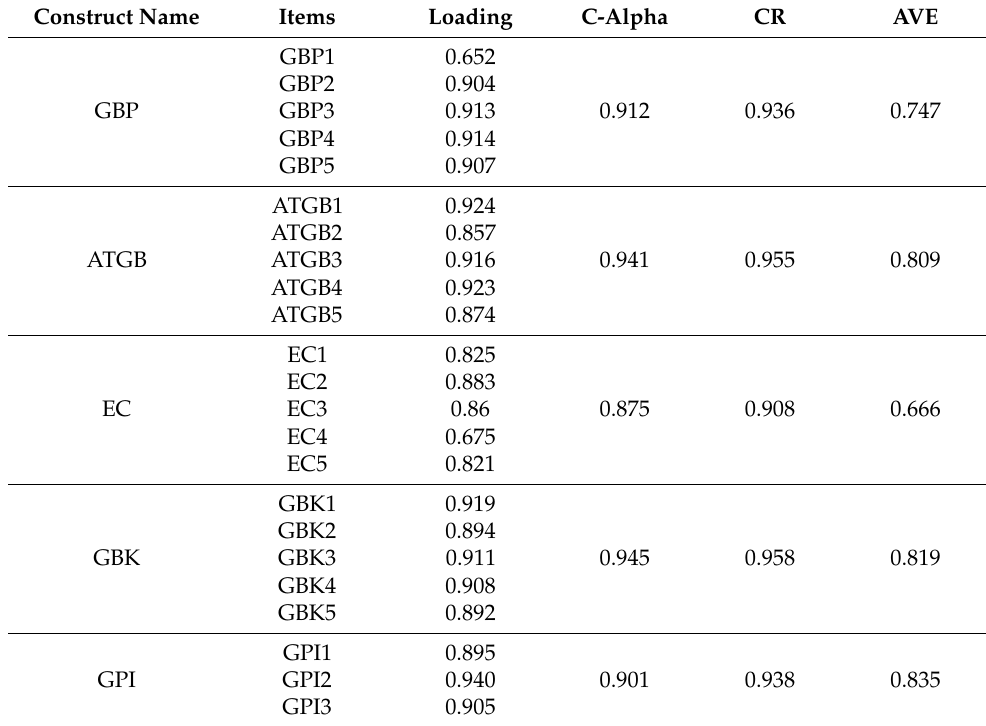
Table 2. Measurement model (factor loading, Cronbach’s Alpha, CR and